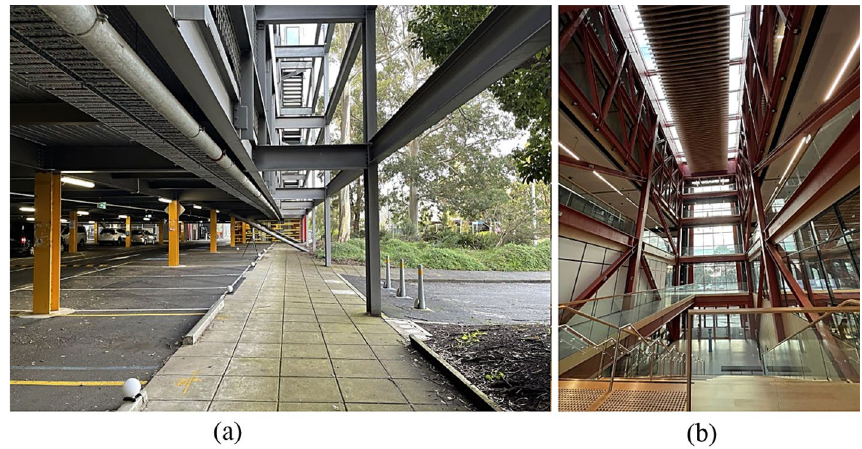
Figure 1. Image of the case study construction projects ( a ) multi-level carpark, and ( b ) Woodside